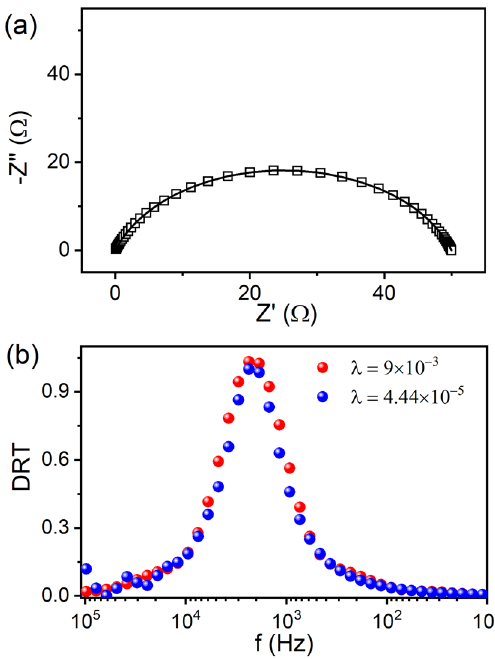
Figure 1. ( a ) Nyquist plots of simulated impedance and ( b ) corresponding DRT spectrum for RC circuit. The solid line is the fit using the code in ( a